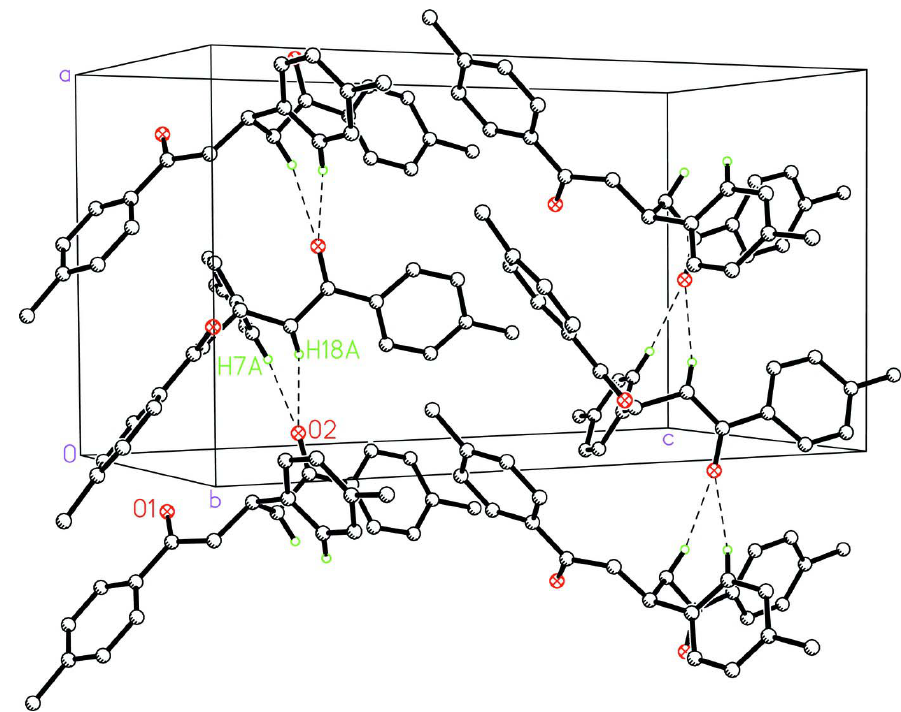
A packing diagram of the title structure, showing the intermolecular C—H···O hydrogen bonds as dashed lines. The H atoms not involved in hydrogen bonding have been omitted for